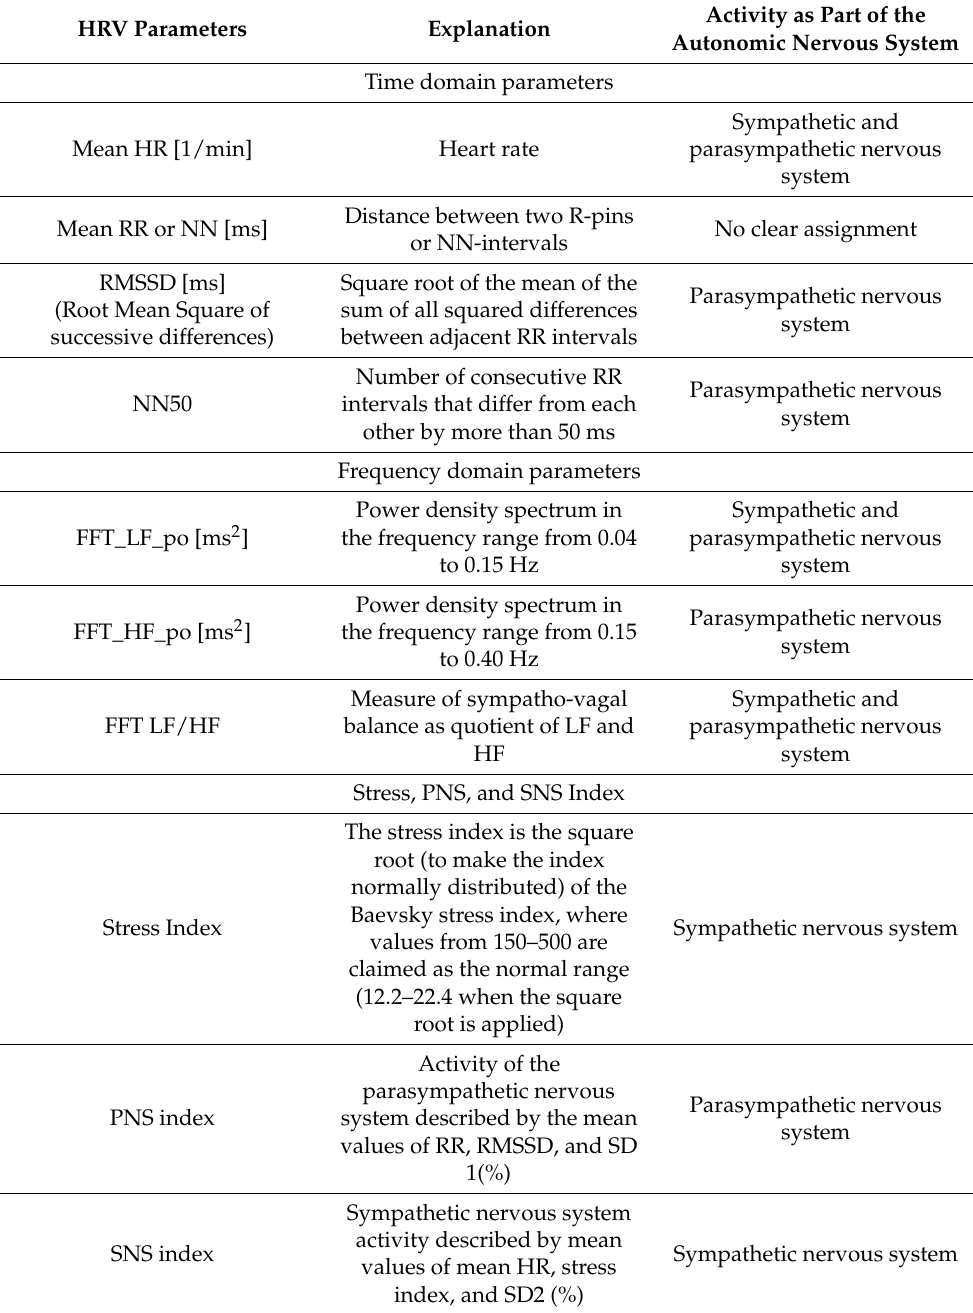
Table 1. Explanation of the HRV parameters used according to the AWMF-s2k guideline